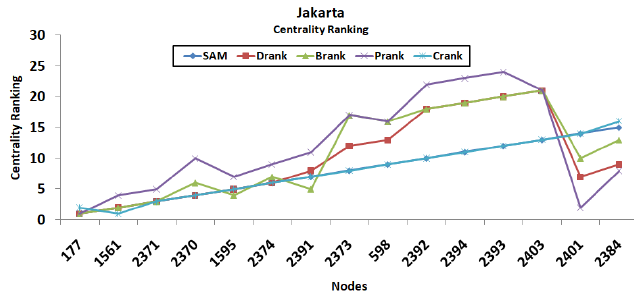
Table 5. Centrality Score of Top 10 Nodes, From Rhodes